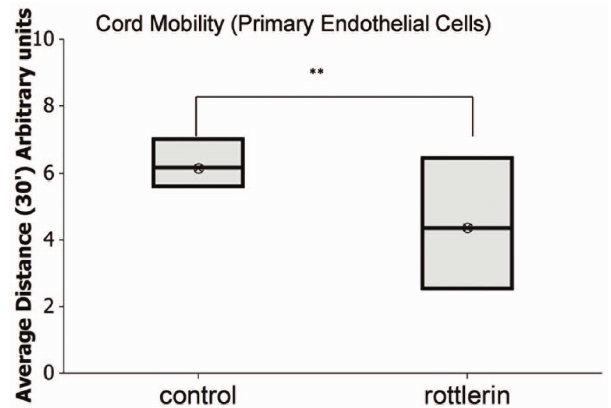
Fiogure 3. PKC d inhibition limits the mobilization/tension on the cords. Quantification of cord motion in supplemental movies 1 and 2. Live cell imaging of cords as they move were quantified with metamorph analysis (Sup. Movie 1/2), as each cord excluding branches were tracked and quantified as average distance displacement for 30 9 (N=14 cords measured; mean 6 SD **P ,